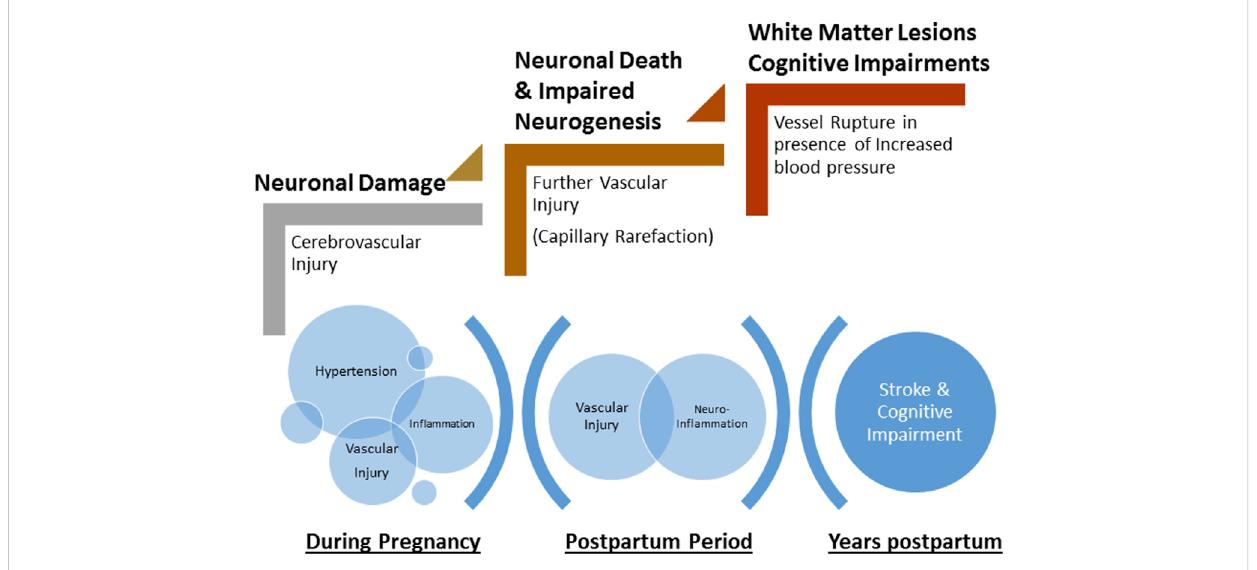
Schematic of the progressive damage to neurons and cerebrovasculature during pregnancy and the postpartum period. Hypertension during pregnancyandassociatedin fl ammationcontributestocerebrovascularinjury.Incompleterepairofneurovasculatureandpersistentin fl ammationleadto further injury including capillary rarefaction and neuronal death during early postpartum period. Microscopic damage and late-life hypertension exacerbate neurovascular damage leading to rupture of vessels (stroke) and cognitive